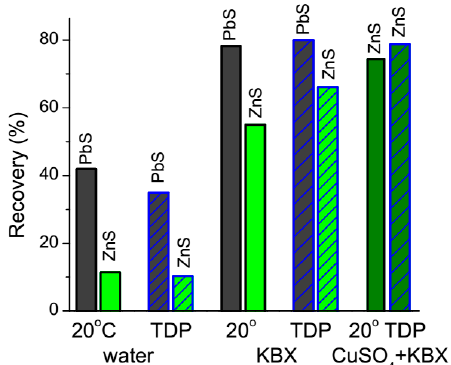
Figure 5. Flotation recoveries of PbS (galena) and ZnS (sphalerite) without (marked as 20 °C) and with the temperature difference pretreatment (TDP, solid heated to 40 °C, water cooled to 2 °C), with 0.1 mM KBX solution, and also with 0.02 mM CuSO 4 and 0.1 mM KBX solution for sphalerite.